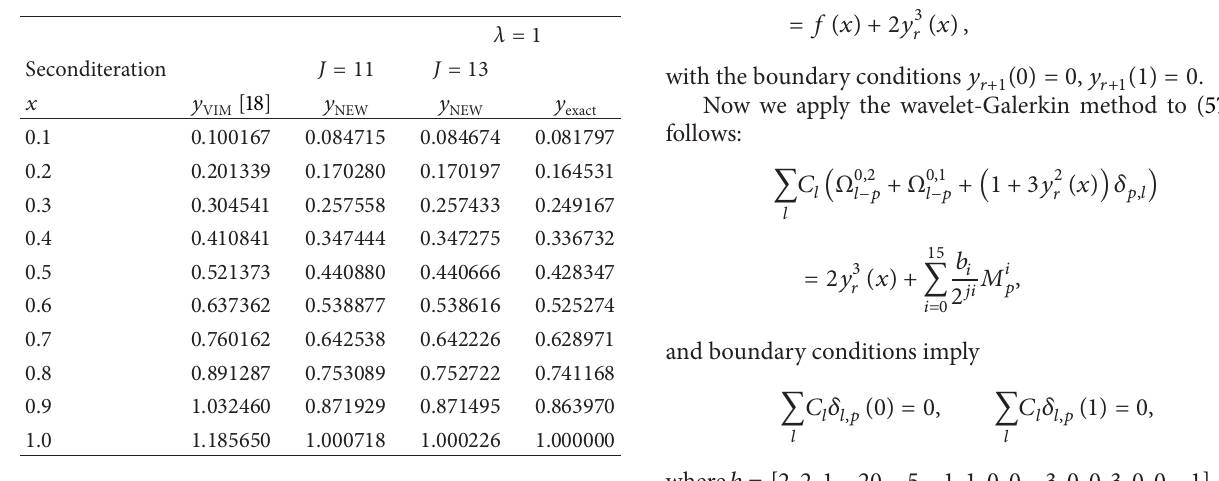
, solution by variational Table 5: Comparison of exact solution 𝑦 exact , and solutions by the wavelet-Galerkin iteration method 𝑦 VIM at second iteration, method with quasilinearization technique 𝑦 NEW at different level of resolutions, and we used 𝐷8 as Galerkin